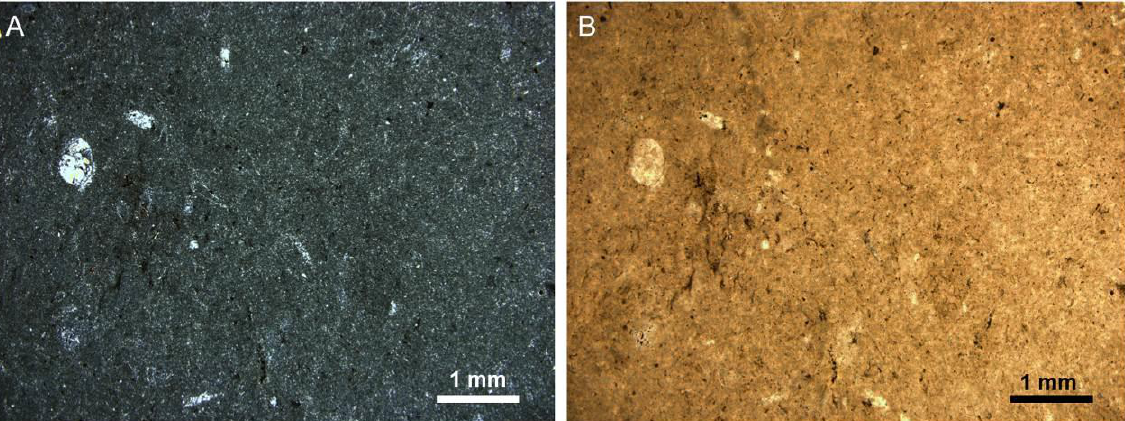
Figure 5. Microscopic appearance of the nodular flint (ARK-01SX). It presents a fine grained texture, micro- cryptocrystalline quartz with ostracods and low concentrations of organic matter. A. Crossed polarisers (xP); and B. the same view with one polariser (1P)